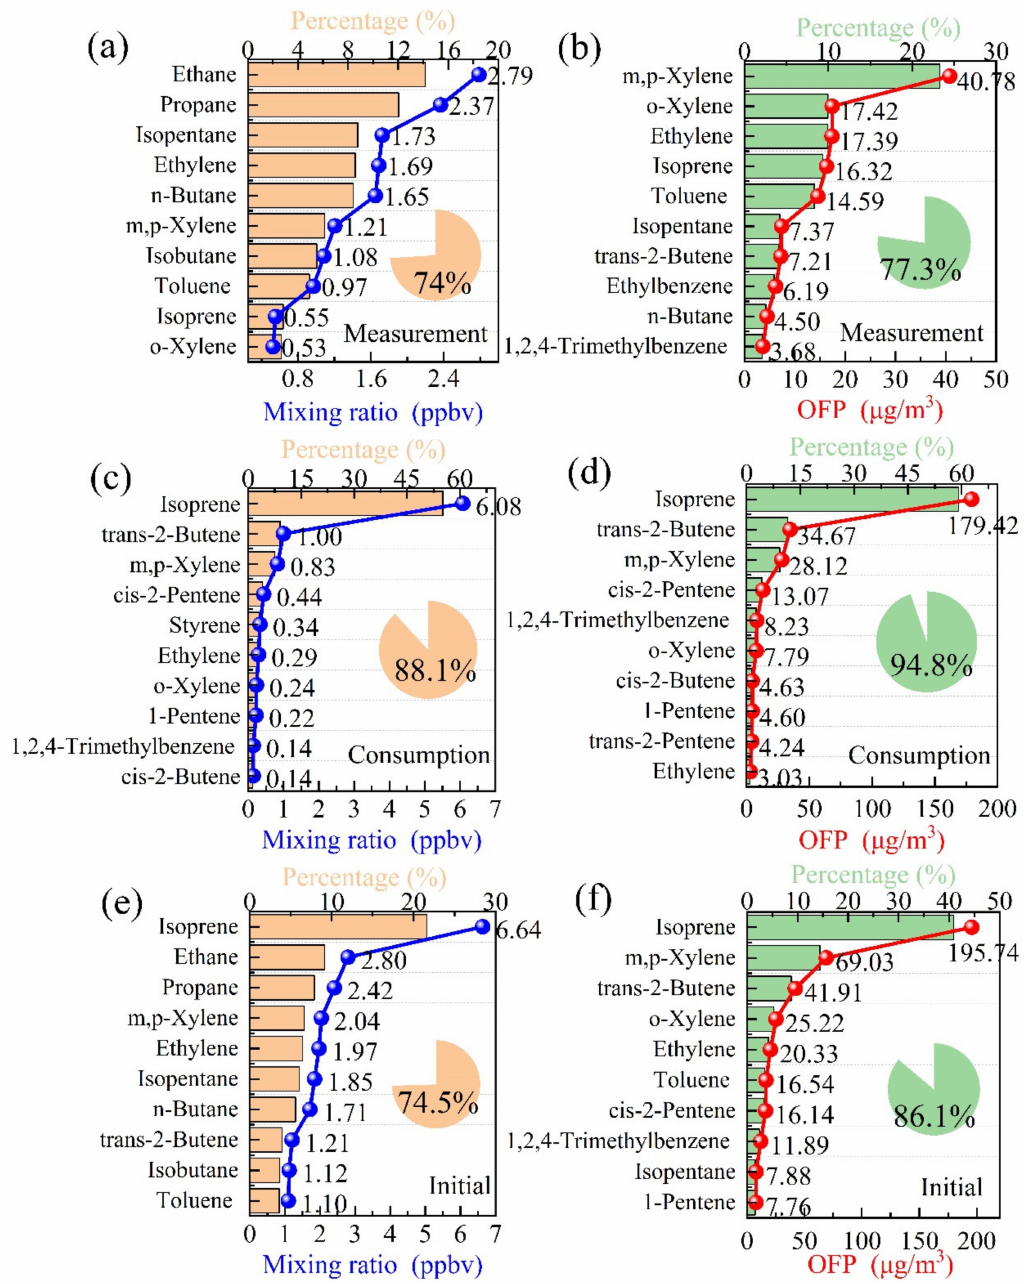
Figure 6. Mixing ratio ( a , c , e ) and OFP ( b , d , f ) of the top ten VOC species during the observation